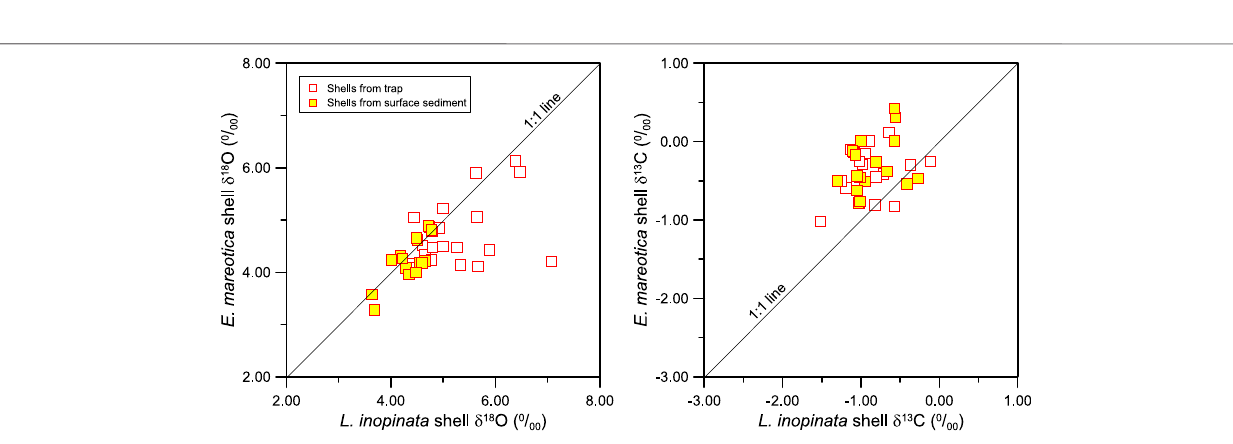
Frontiers in Earth Science |